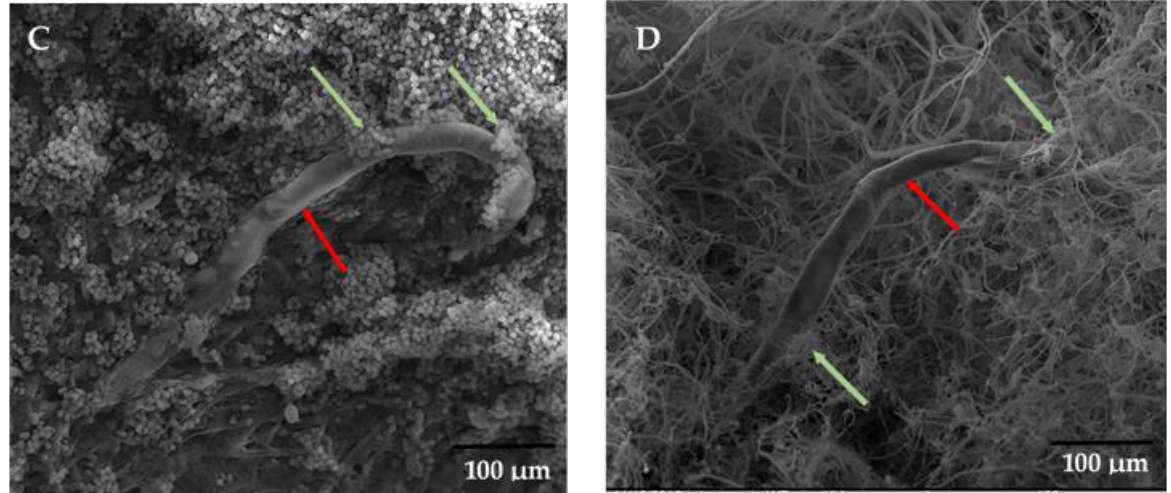
Figure 1. Scanning electron micrographs of Meloidogyne javanica second stages juveniles treated with Trichoderma harzianum ( A , B ), T. longibrachiatum ( C ), and Metacordyceps chlamydosporia ( D ) (( A ): scale bars 300 µm; ( B ): scale bars: 50µm; ( C ) and ( D ): 100 µm; red arrows indicate the nematode juveniles; green arrows indicate the fungus mycelium).